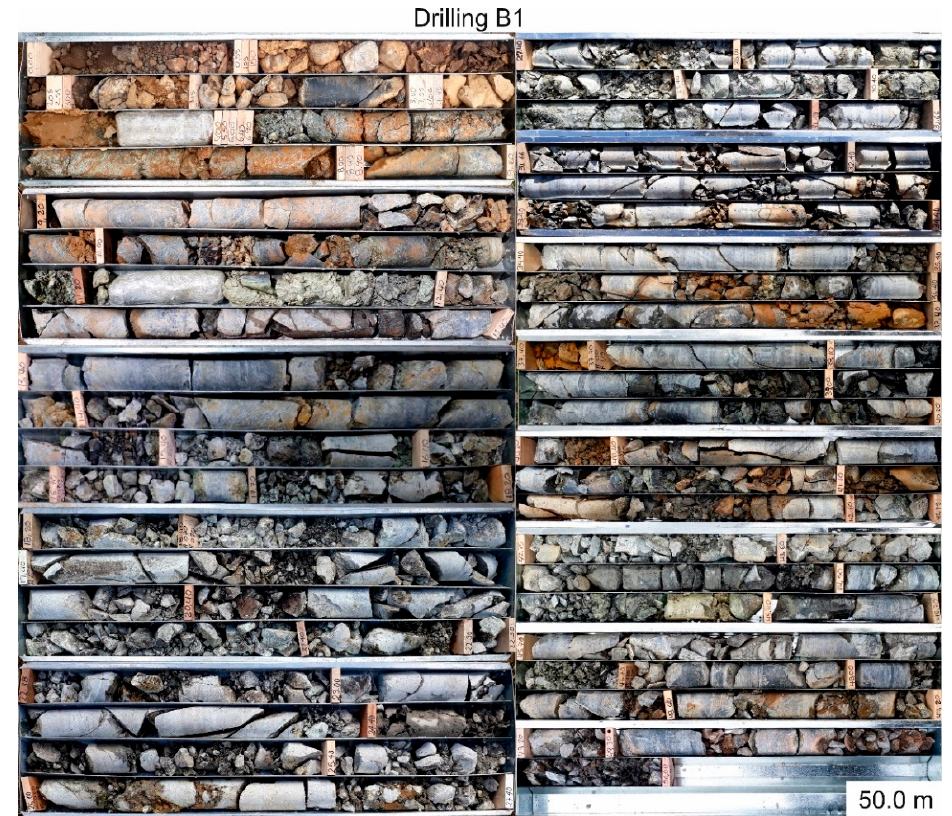
Figure 7. Picture of the drilling core B1, depicted in two rows. The left row shows the drilling core from 0–27.4 m, the right row shows the drilling core from 27.4–50.0 m. The core boxes have a length of 1 m each and run from top left to bottom right.